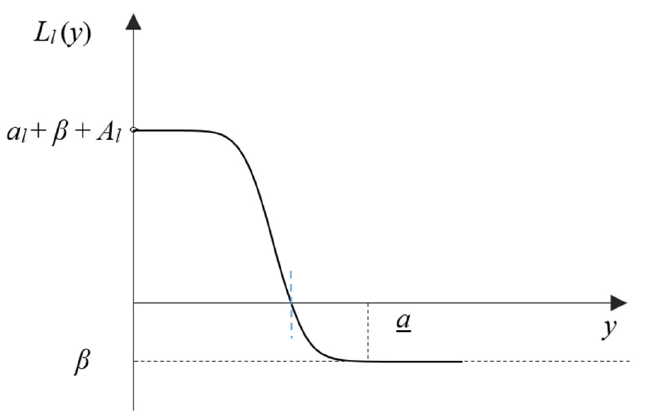
Figure 5. Grey quality gain-loss function curve with larger-the-better characteristics curve (hyperbolic tangent